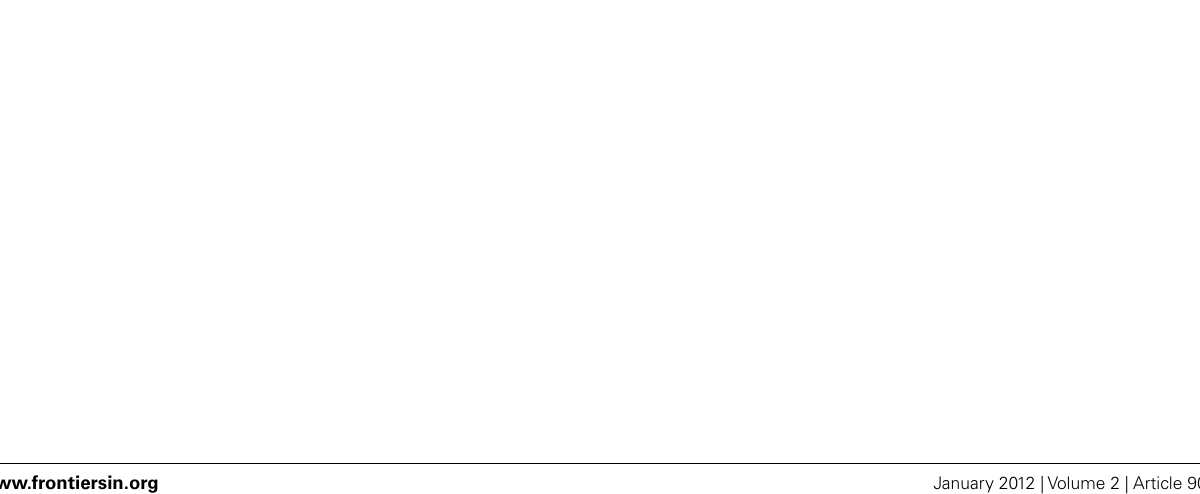
FIGUREA7 | Distribution of coverage and Phred scores of